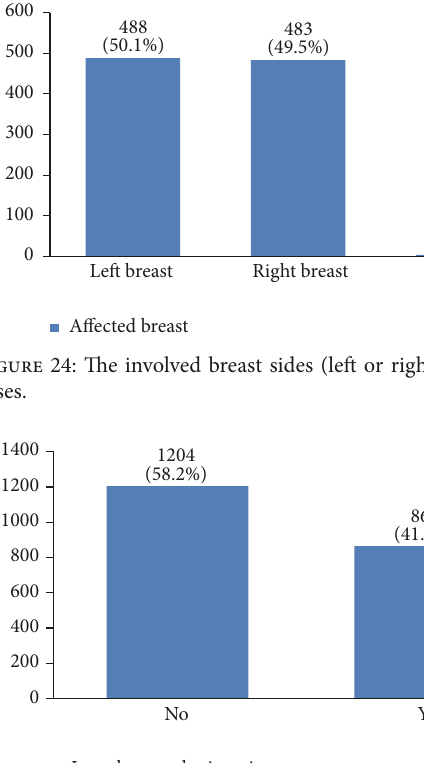
Figure 21: The tumor grade of the studied breast cancer cases.